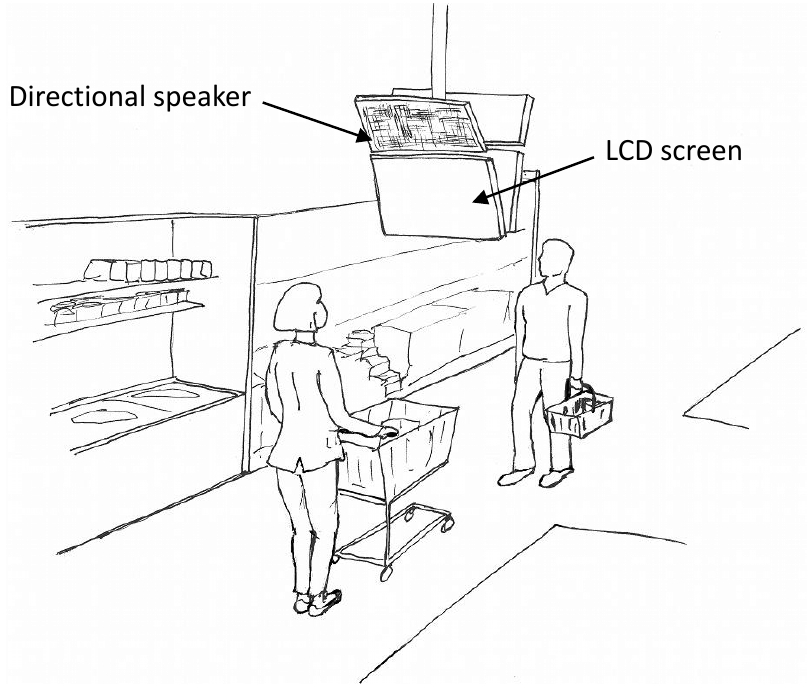
Figure 10. Conceptual drawing of an information screen with directional audio